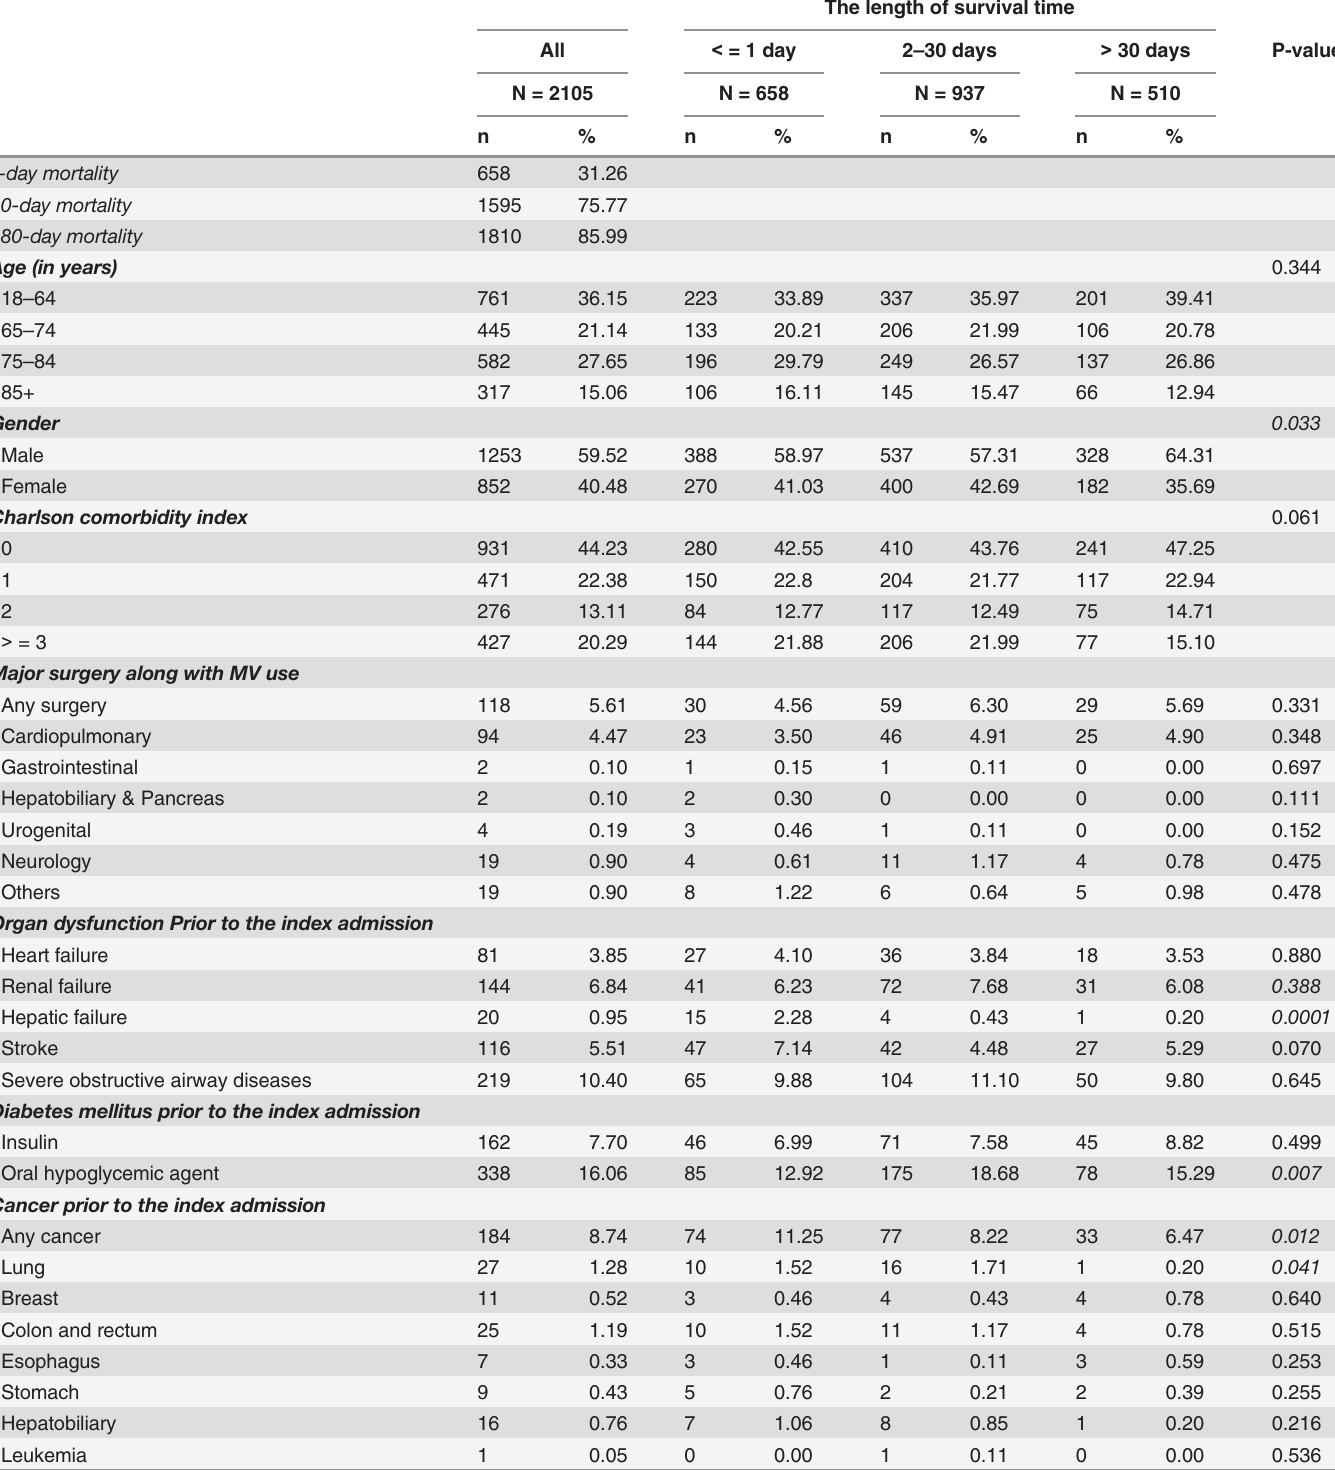
Table 5. Demographic and clinical characteristics among OHCA patients requiring MV care during the hospital stay in 2010 – 2011, by the length of survival